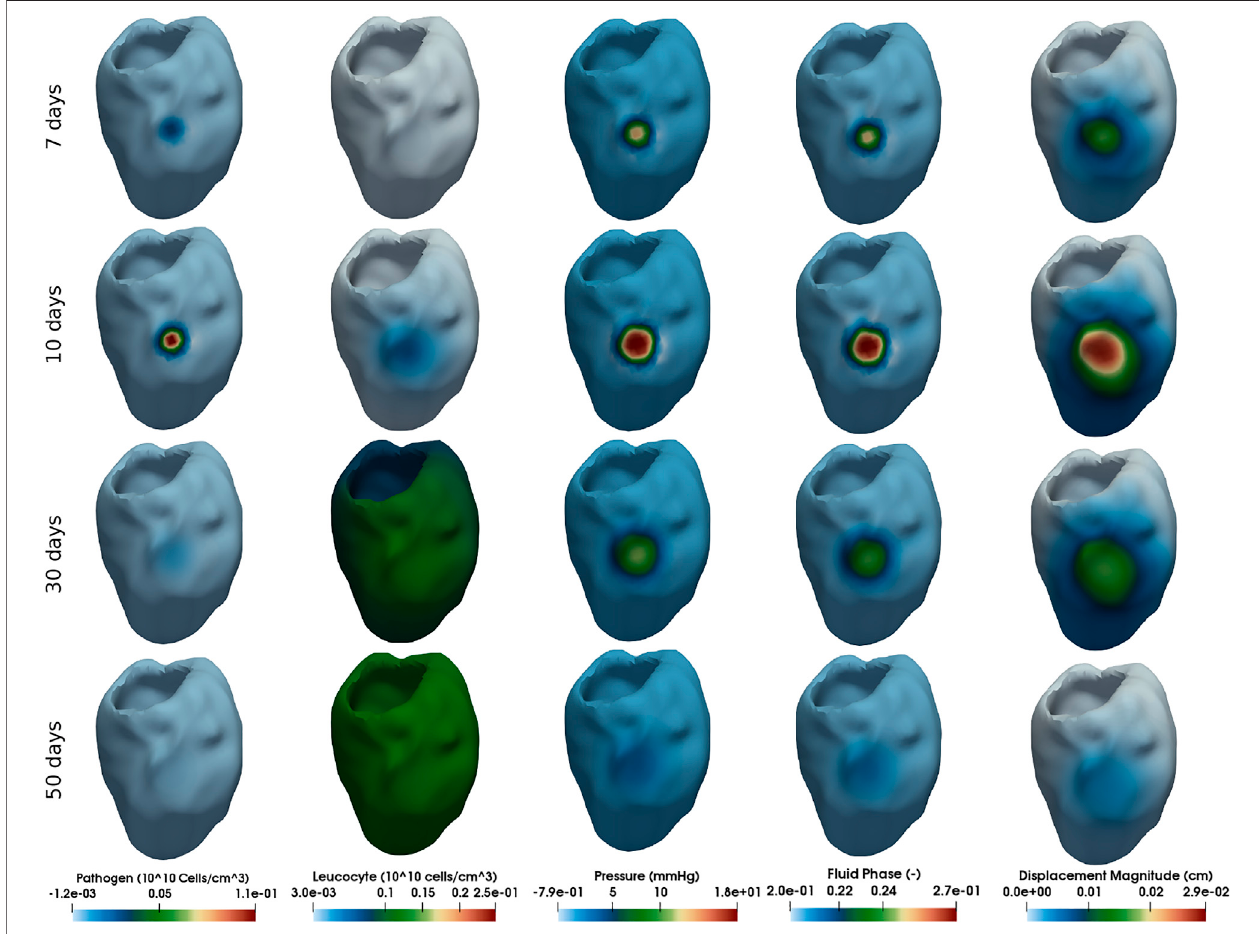
FIGURE 3 | Simulation of local myocarditis in a 3D patient-speci fi c heart geometry using the reference parameter values described in Tables 1 , 2 (those from column Local Myocarditis). The rows present snapshots of the solution at different time instants (7, 10, 30, and 50 days) for each variable (columns).